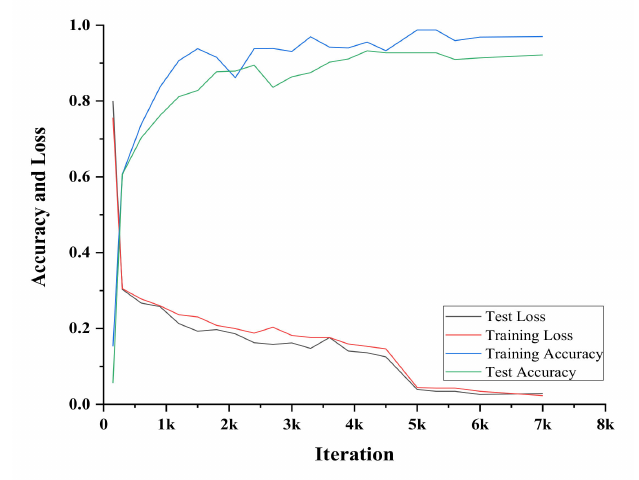
Figure 16. Accuracy of Training or